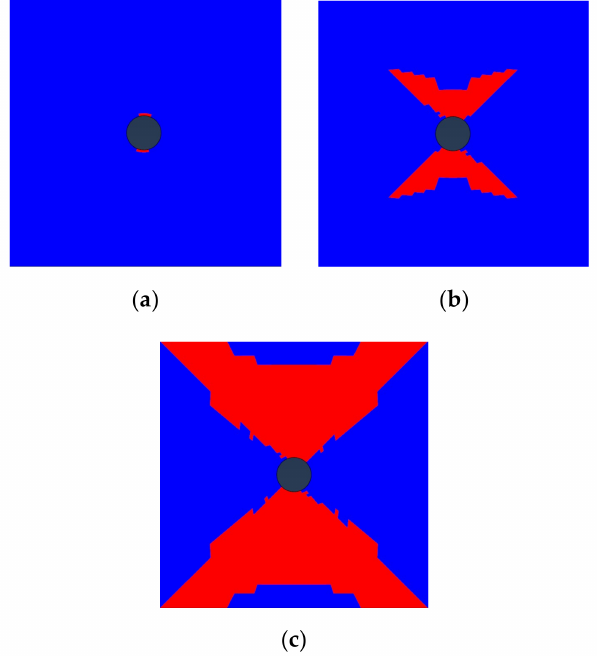
Figure 8. Damage and failure paths in 45 ◦ layer of laminated plates using the Hashin method. ( a ) initial damage; ( b ) damage at 90 percent failure; ( c ) damage at ultimate load.